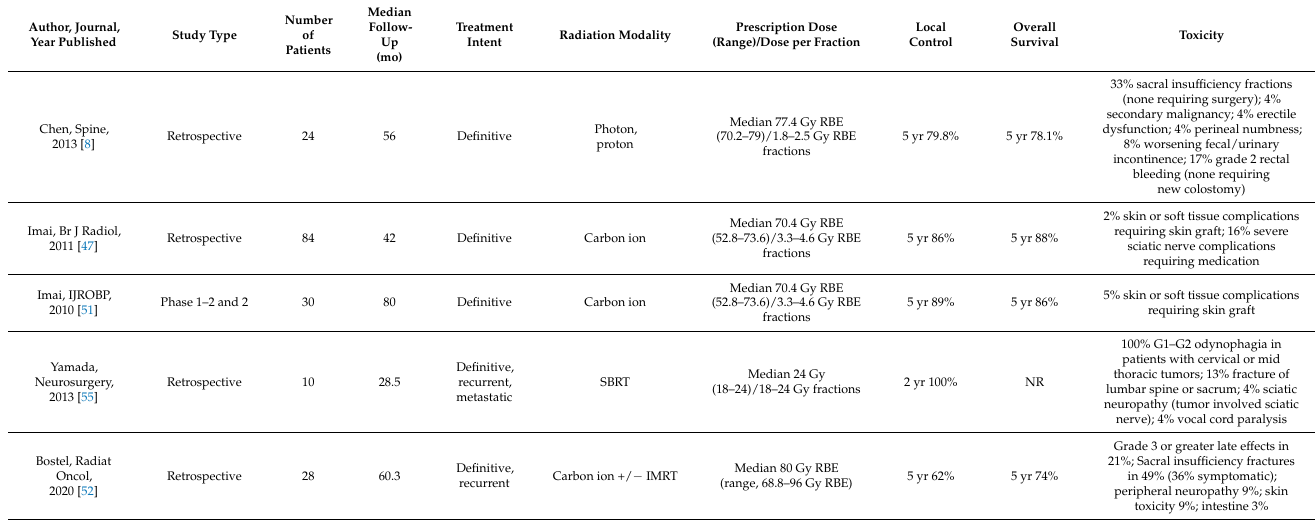
Table 4. Data summary of studies reporting outcomes of patients with spinal and sacral chordomas treated with radiation therapy